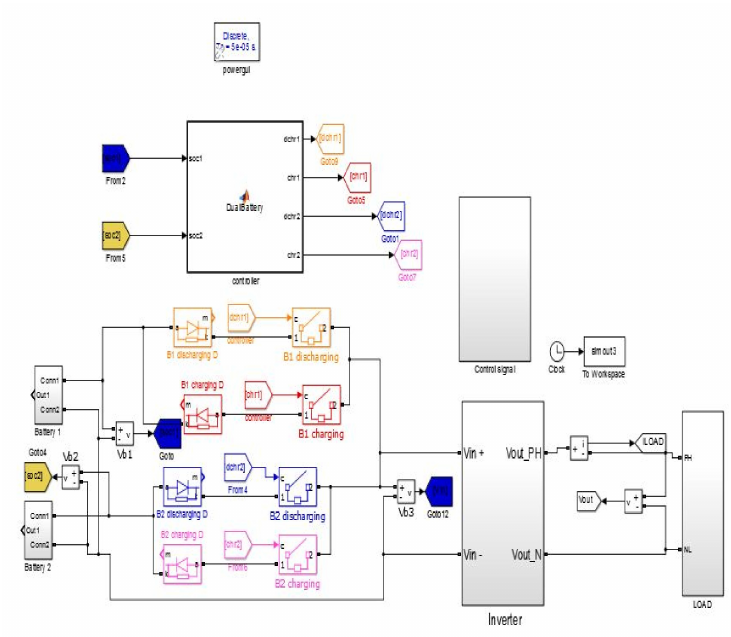
Figure 4. MATLAB Simulink diagram for the dual battery algorithm.